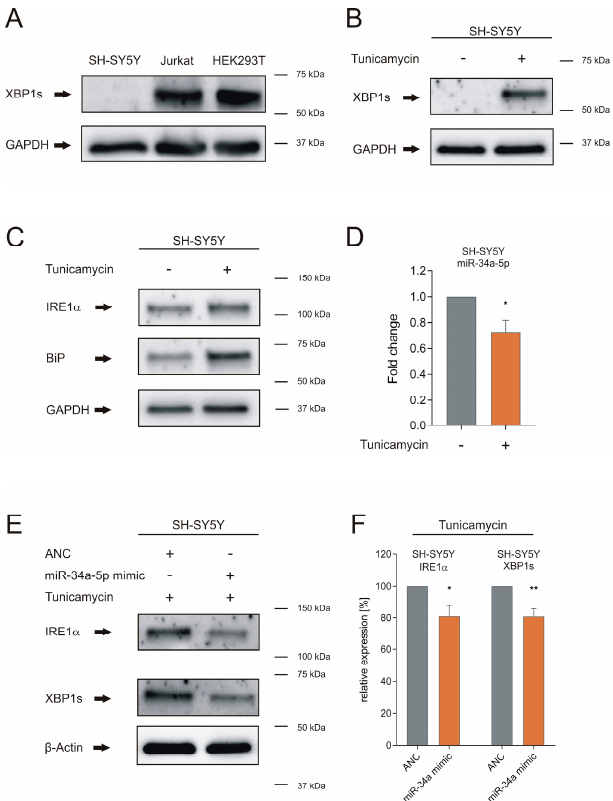
Figure 4. Induction of the UPR by tunicamycin in neuronal SH-SY5Y cells. ( A ) XBP1s endogenous protein level in SH-SY5Y, Jurkat and HEK293T cells. Proteins of SH-SY5Y, Jurkat and HEK293T cells were isolated, and western blotting was performed using XBP1s-specific antibody. GAPDH served as the endogenous control. ( B ) Endogenous XBP1s protein after tunicamycin treatment in SH-SY5Y cells. SH-SY5Y cells were treated with tunicamycin for 4 hours, and western blotting was performed using XBP1s-specific antibody. GAPDH served as endogenous control. ( C ) Detection of endogenous protein levels of IRE1 α and BiP after tunicamycin treatment. SH-SY5Y cells were treated with tunicamycin for 4 hours and western blotting was performed using IRE1 α - and BiP-specific antibodies. GAPDH served as the endogenous control. ( D ) Analysis of miR-34a-5p after tunicamycin treatment in SH-SY5Y cells by qRT-PCR. SH-SY5Y cells were treated with tunicamycin for 4 hours. RNA was isolated and qRT-PCR was performed using miR-34a-5p-specific primer. Data represent mean ± SEM of three independent experiments ( p ≤ 0.05). ( E ) Representative western blot of IRE1 α and XBP1s protein levels in miR-34a-5p overexpressing SH-SY5Y cells after tunicamycin treatment. SH-SY5Y cells were transfected with AllStars Negative Control (ANC) or miR-34a-5p mimic. At 48 hours post transfection, cells were treated with tunicamycin for an additional 4 hours. Endogenous protein levels of IRE1 α and XBP1s were analyzed by western blotting using specific antibodies against IRE1 α and